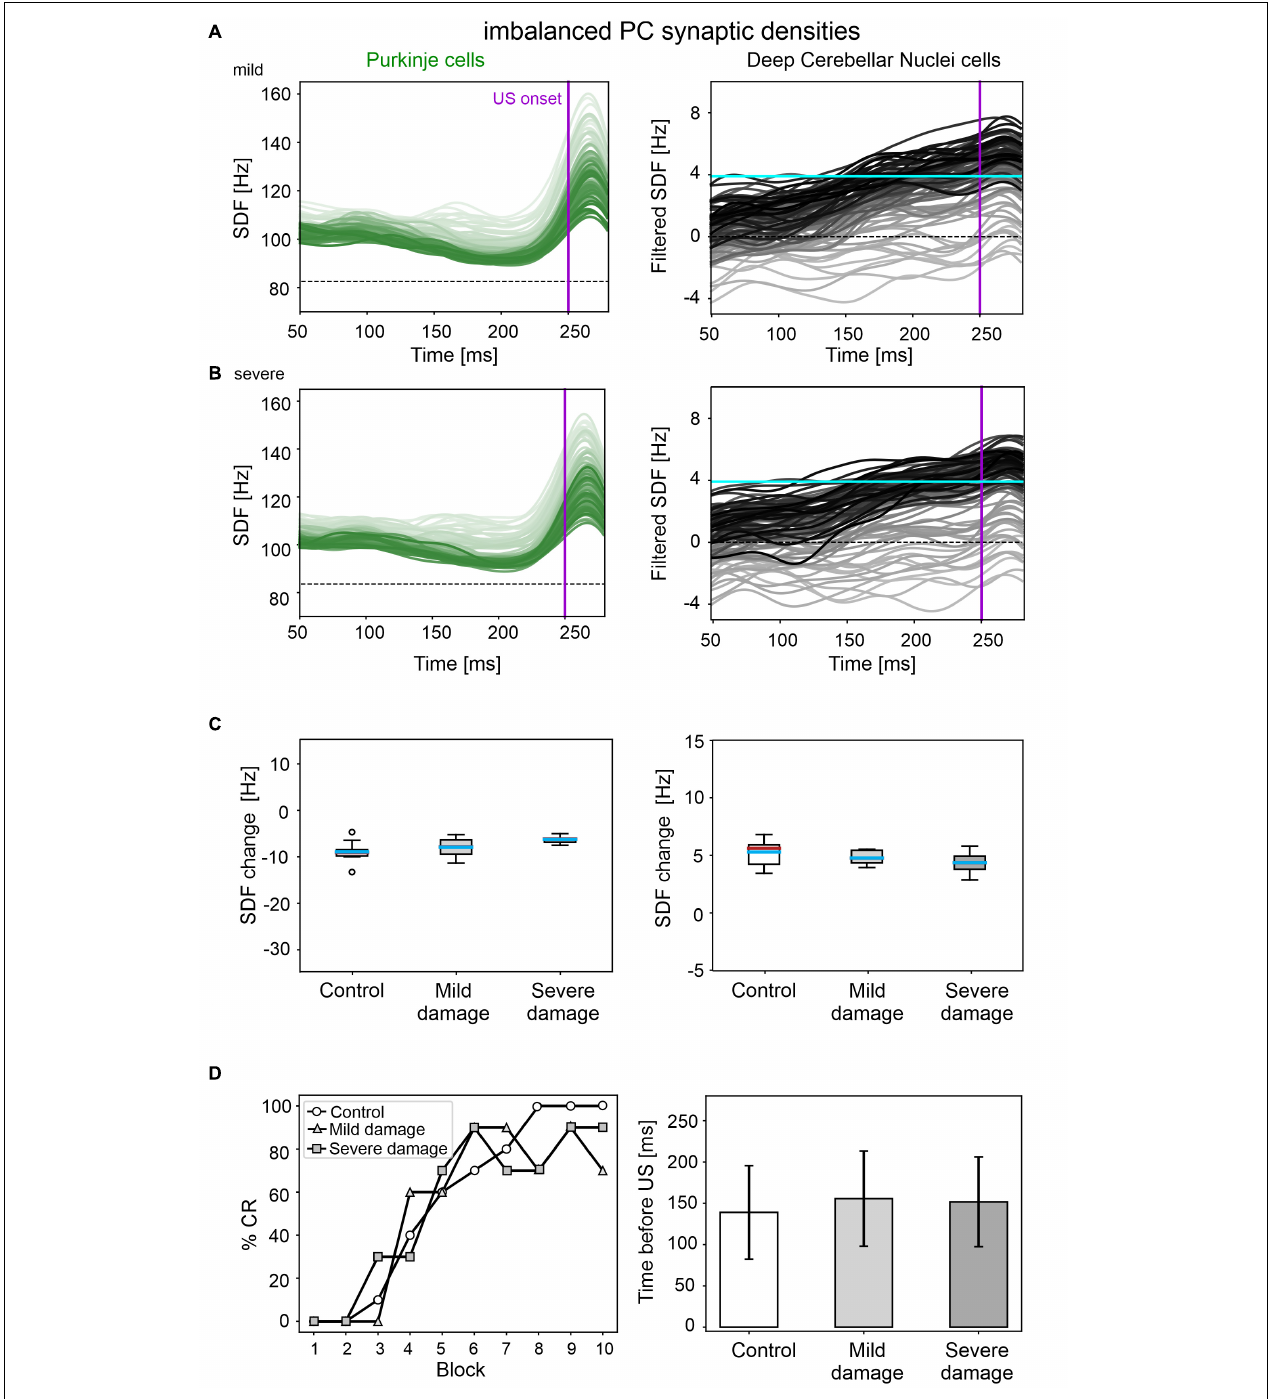
FIGURE 6 | EBCC simulations in the case of imbalanced PC synaptic densities. SDF in PC population and DCN motor output (averaging across cell SDFs) for each trial (0 ms is aligned with the CS onset), with mild (A) and severe damage (B) . Increasing darkness of the lines corresponds to subsequent trials (the lightest is the first trial, the darkest is the last trial). Dashed horizontal line indicates baseline activity, solid horizontal cyan line (right panels) represents CR threshold. Purple vertical line corresponds to US onset time. (C) SDF change in PC (left) and DCN (right) populations from the 10 trials in the last block, with respect to SDF value in the first 100 ms from CS onset. Cyan horizontal line indicates the mean, red horizontal line the median, box edges the 1st and 3rd quartile, whiskers the minimum and maximum accepted values, excluding outliers (indicated as circles). (D) Behavioral EBCC outcome, i.e., %CR along trial blocks (left panel), and CR timing with respect to US onset (right panel), compared to the control condition. Error bars indicate the standard